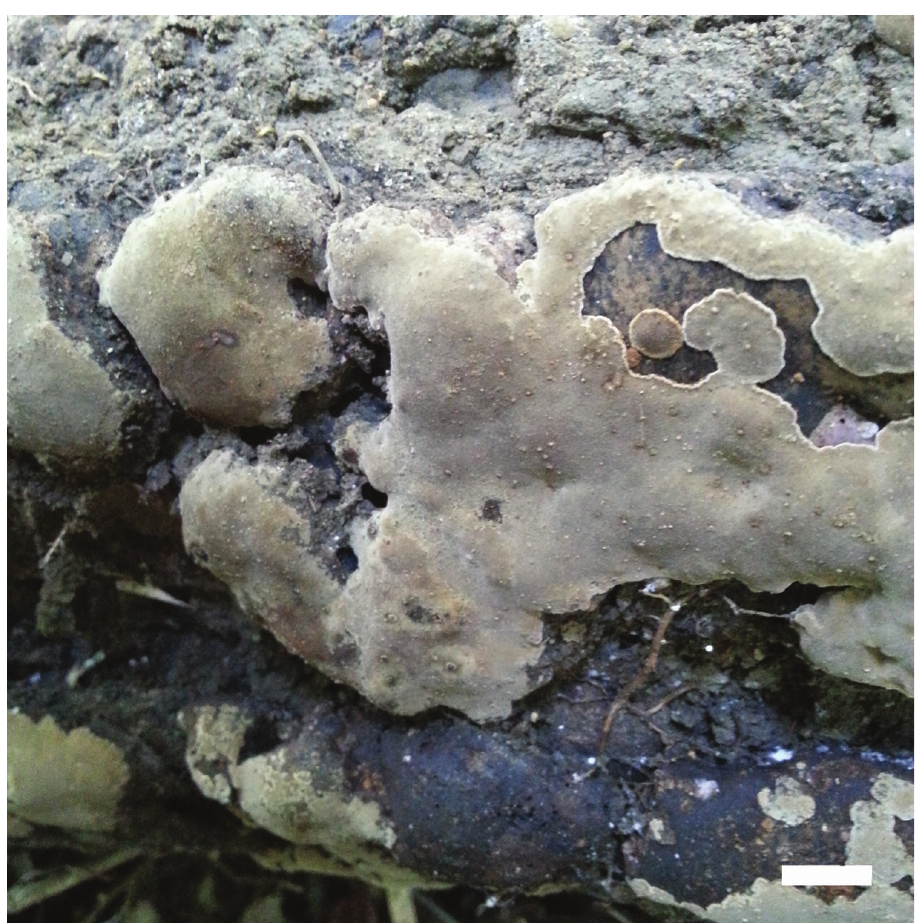
Figure 3. A basidiocarp of Fomitiporella austroasiana . Scale bar: 1